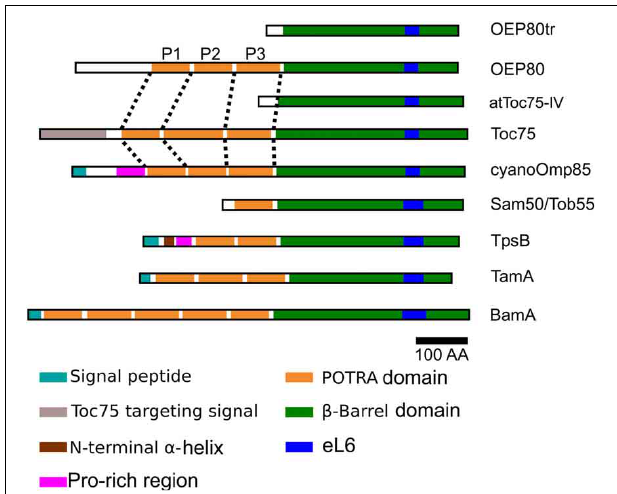
FIGURE 1 | Molecular architecture of the Omp85 family proteins. Omp85 homologs are comprised of an N-terminal soluble portion containing a variable number of POTRA domains (orange) followed by a C-terminal transmembrane β -barrel (green). The POTRA domains 1, 2, and 3 of the chloroplast and cyanobacteria homologs are indicated as P1, P2, and P3, respectively. Unlike the others, OEP80tr and Toc75-IV do not contain any full POTRA domains although they both contain sequences that align well with the last β -strand of P3 in their relatives. Within the β -barrel that is made of 16 transmembrane β -strands, strands 11 and 12 are separated by the 6th extracellular loop (blue) which contains a sequence highly conserved between all Omp85 homologs. The homologs from bacteria contain a signal peptide (turquoise) that is required for protein export from the cytoplasm to the periplasm. Toc75 contains a unique bipartite targeting signal (gray) at its N terminus and an apparent unique insertion at the beginning of its second POTRA domain. Cyanobacterial Omp85 homologs and TpsB contain a Pro-rich region (pink) N terminus to the first POTRA domain. In addition, TpsB contains an α -helix (brown) N terminus to the Pro-rich region. The domain lengths are approximately to